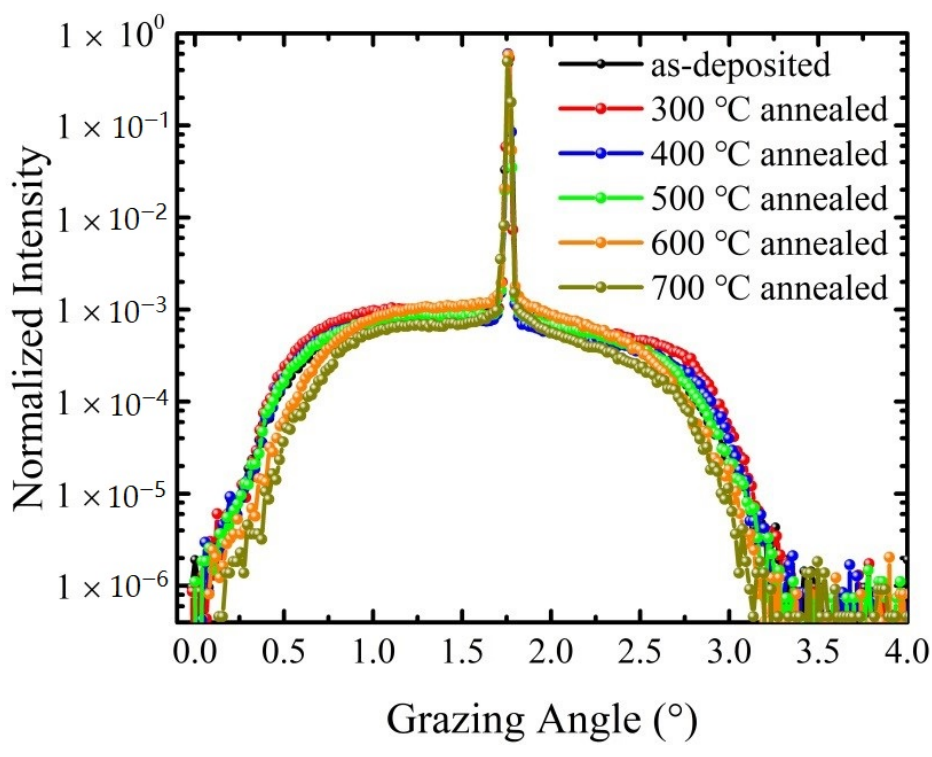
Figure 4. X-ray scattering measurements (rocking-curve scan mode) of Ru/C multilayers under different annealing temperatures.